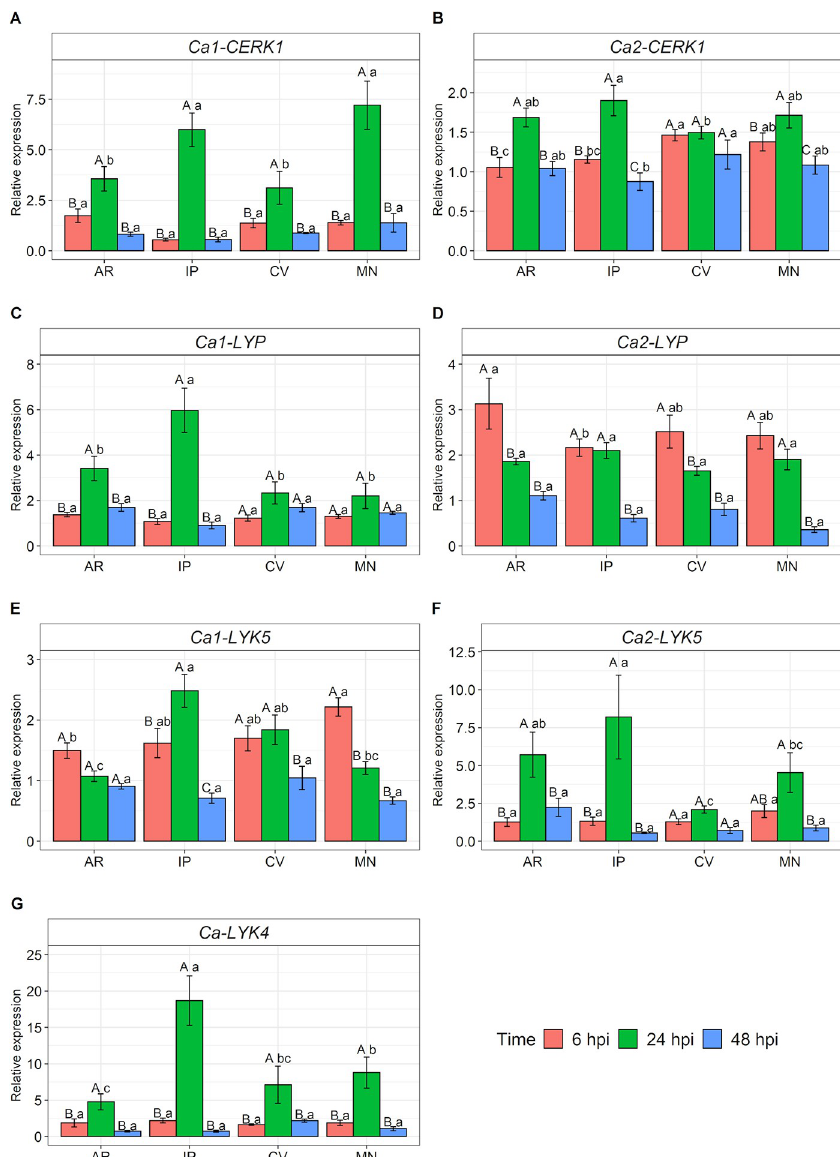
Fig 5. Relative expression of candidate genes for CERK1 , LYP (CEBiP-like), LYK5 and LYK4 in C . arabica . (A) Ca1-CERK1 , (B) Ca2-CERK1 , (C) Ca1-LYP , (D) Ca2-LYP , (E) Ca1-LYK5 , (F) Ca2-LYK5 , (G) Ca-LYK4 . Candidate genes were evaluated in C . arabica leaves at 6, 24 and 48 hours post-inoculation (hpi) with H . vastatrix . The average of relative expression was obtained by the ratio between the means of inoculated and control (not inoculated). Capital letters represent the statistical analysis of the times for each cultivar and lower letters between cultivars. Means followed by the same letter are not differentiated by Tukey’s test at 5% probability. The data shown represents experiments 1 and 2. MN: Mundo Novo, CV: Catuaı´Vermelho IAC 144, AR: Aran ã s RV, IP: IAPAR-59.